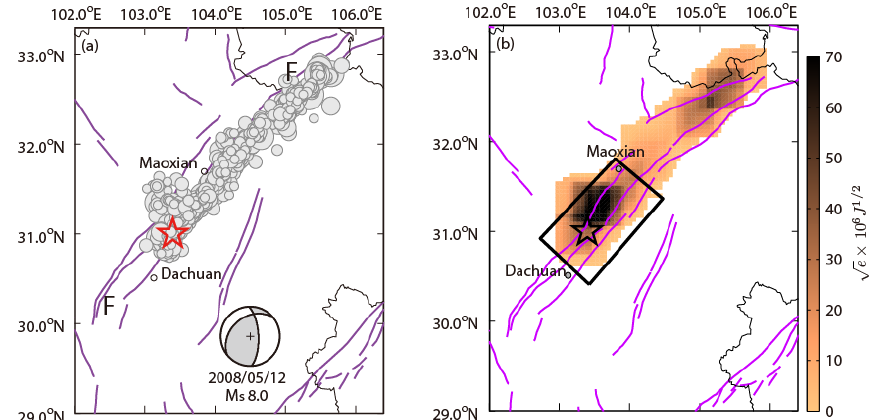
Figure 1. (a) Map showing the locations of aftershocks ( M L ≥ 3 . 0 ) following the Wenchuan event from 12 May to 31 August 2008. The focal mechanism solution comes from the Global Centroid Moment Tensor (CMT) catalog. “F” represents the Longmenshan fault. (b) The spatial distribution of seismic strain for the aftershocks that occurred from 12 to 31 May 2008. The star shows the epicenter of the Wenchuan event. The quadrangle shows the study region.